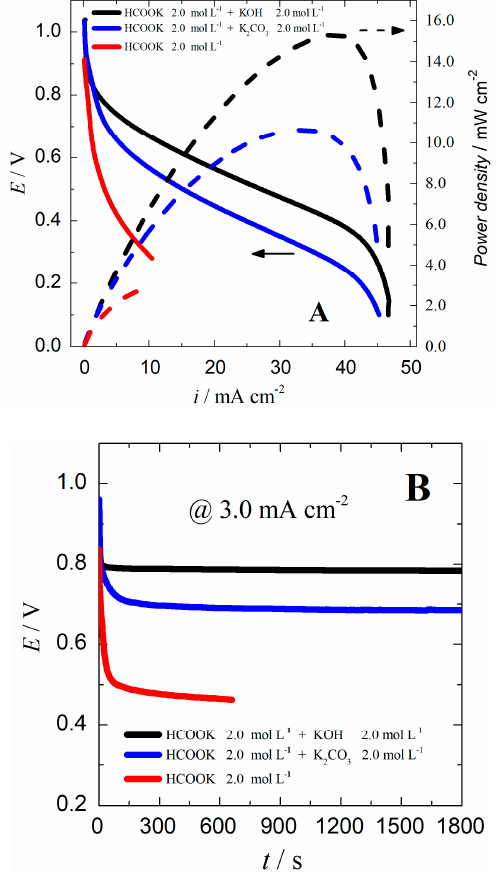
Figure 8. ( A ) Potentiodynamic curves and the corresponding power densities obtained in the passive air-breathing direct formate fuel cell and; ( B ) Chronopotentiometric curves obtained at 3.0 mA cm − 2 in different electrolytes, as indicated in the figure inset. Cathode: FeCo-N-C; Anode: PdPt/C 4:1. All measurements were recorded at 25 °C.